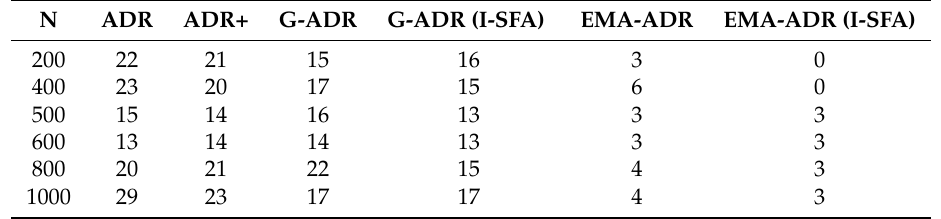
Convergence period in hours for mobile EDs (with starting SF = 12, uplink period = 24 packets/day, total simulation time = 4 days).